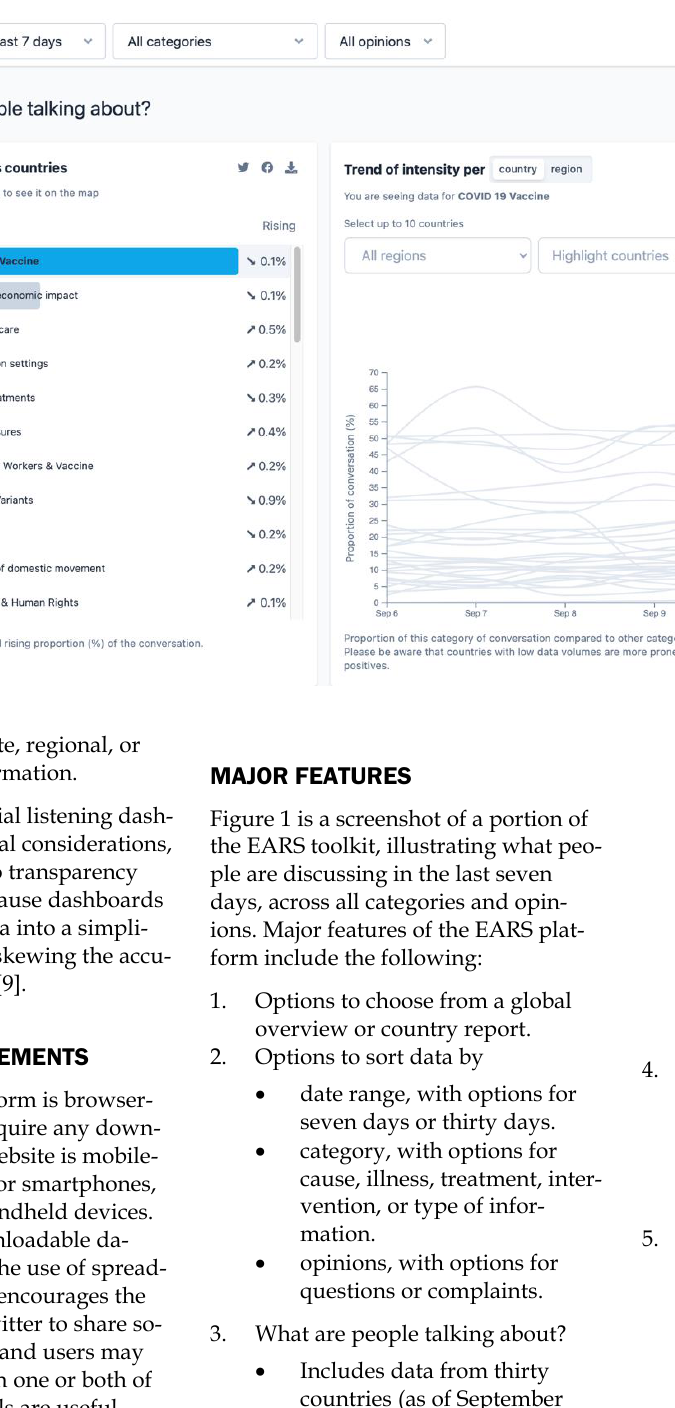
Figure 1 EARS graphs illustrating COVID-19 topics being discussed across 30 countries